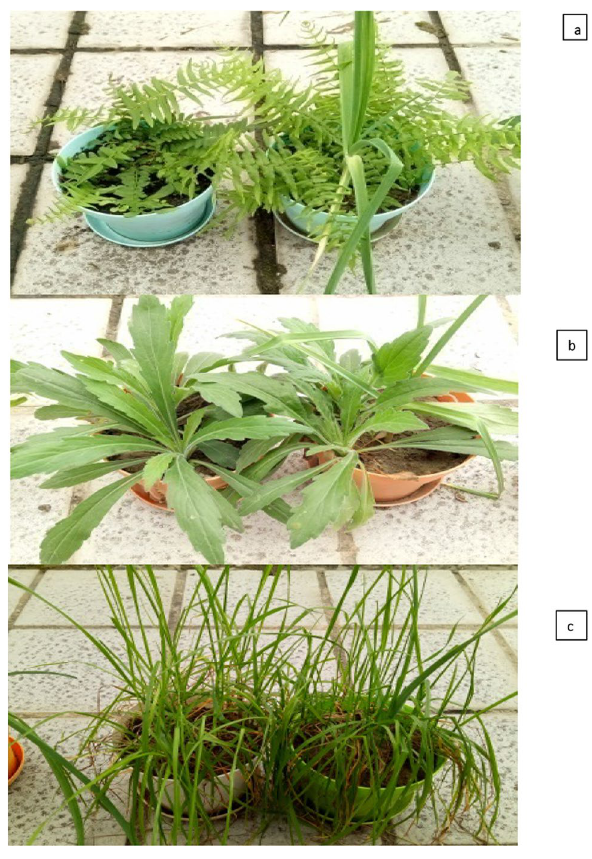
Figure 1. Single planting and inter-planting treatments of Garlic with P. vitatta ( a ), Conyza canadensis ( b ) and Lolium perenne ( c ).